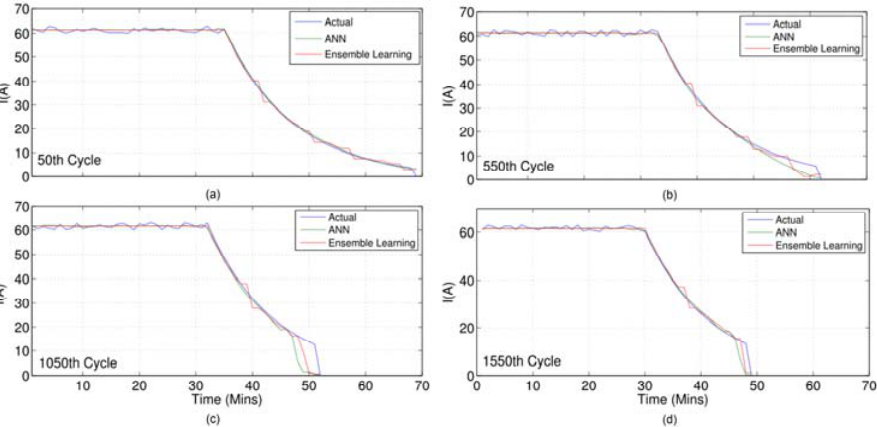
Figure 11. Charging profiles predictions for non-uniform aging of cells—Scale 1. ( a ) 50th Cycle; ( b ) 550th Cycle; ( c ) 1050th Cycle; ( d ) 1550th Cycle.